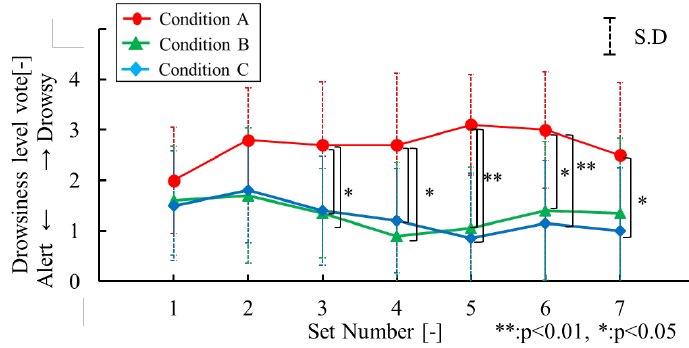
Figure 5. Results of the value of the drowsiness level sensation vote.